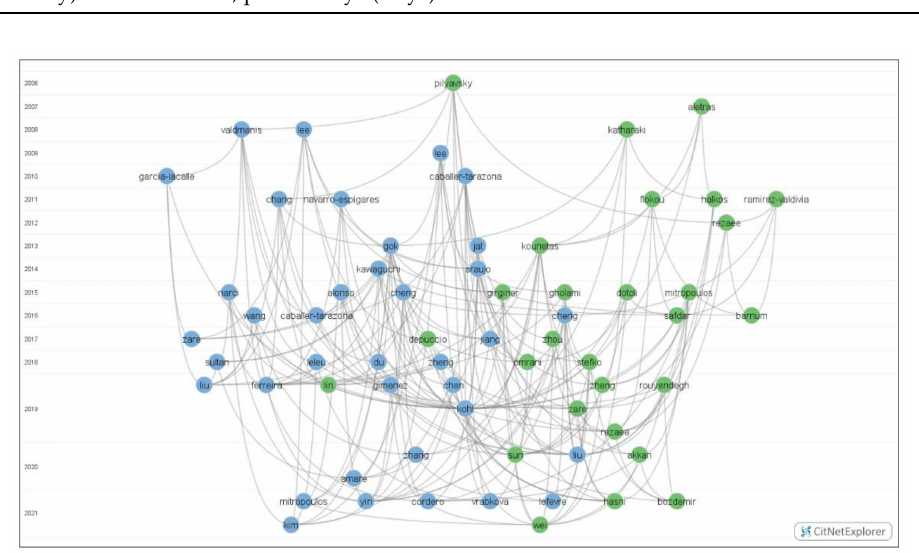
Figure 3. Timeline-based network visualization for the core